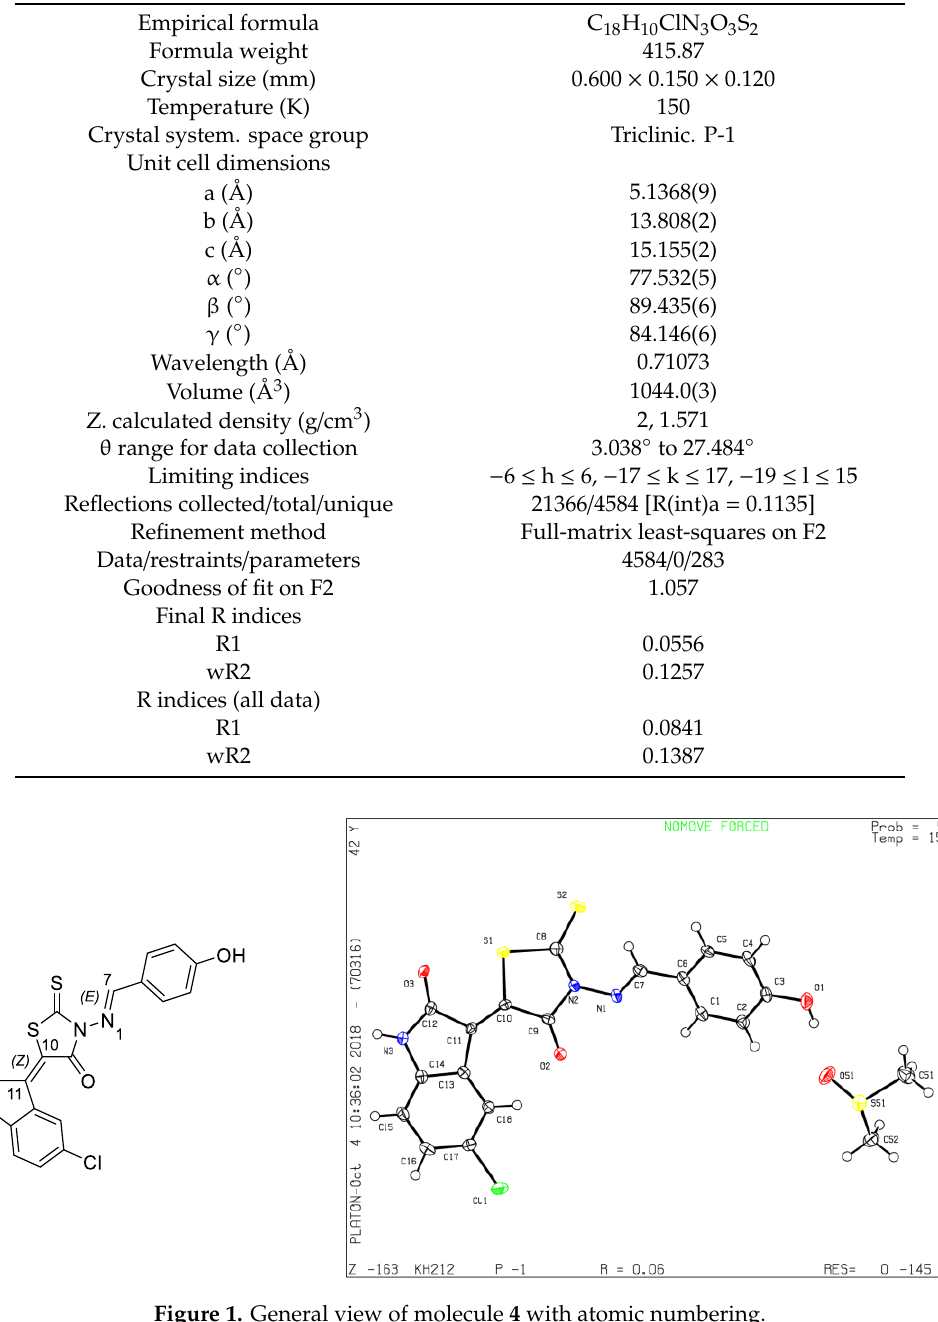
Figure 1. General view of molecule 4 with atomic numbering. Table 1. Crystal data and structure refinement details .